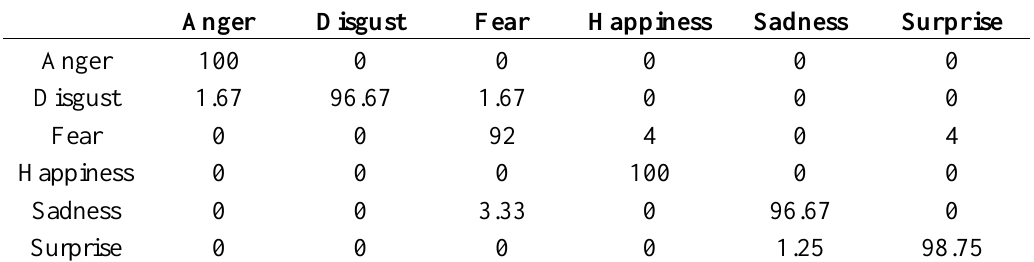
Table 6. Confusion matrix for facial expression recognition in percentages, using SVM with boosted features (400 AdaBoost selected